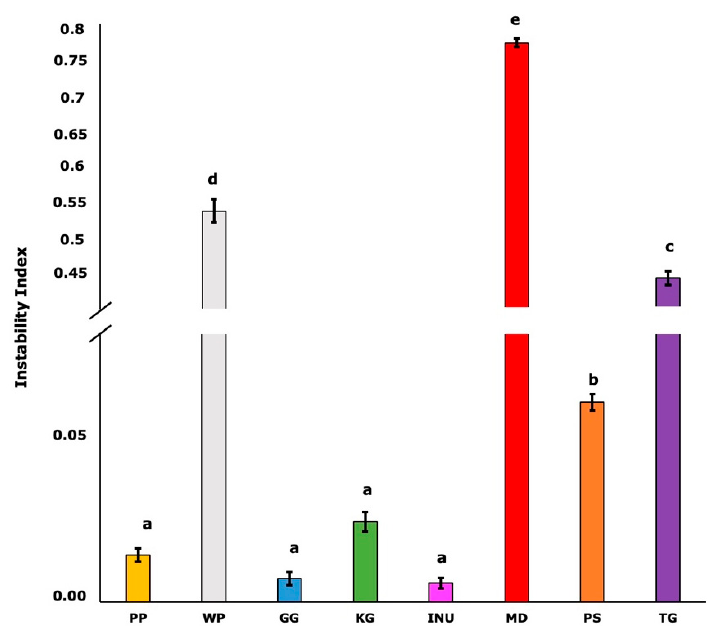
Figure 3. Instability index of the analyzed biopolymers. According to Turkey’s test, the values followed by the same letter (a–e) do not differ significantly ( p > 0.05).